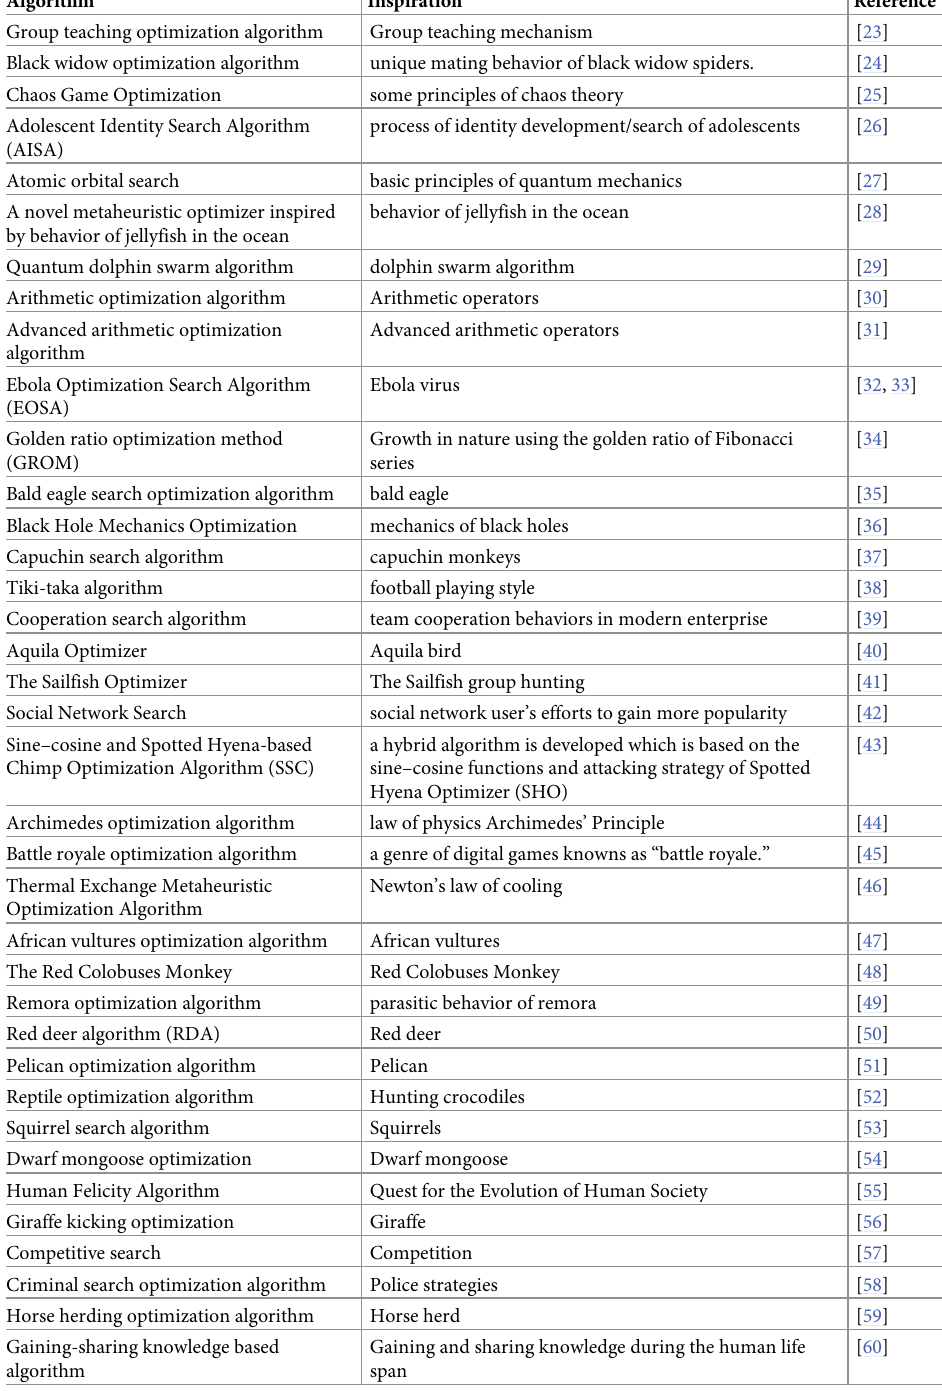
Table 1. Some nature-inspired metaheuristic algorithms with their source of inspiration